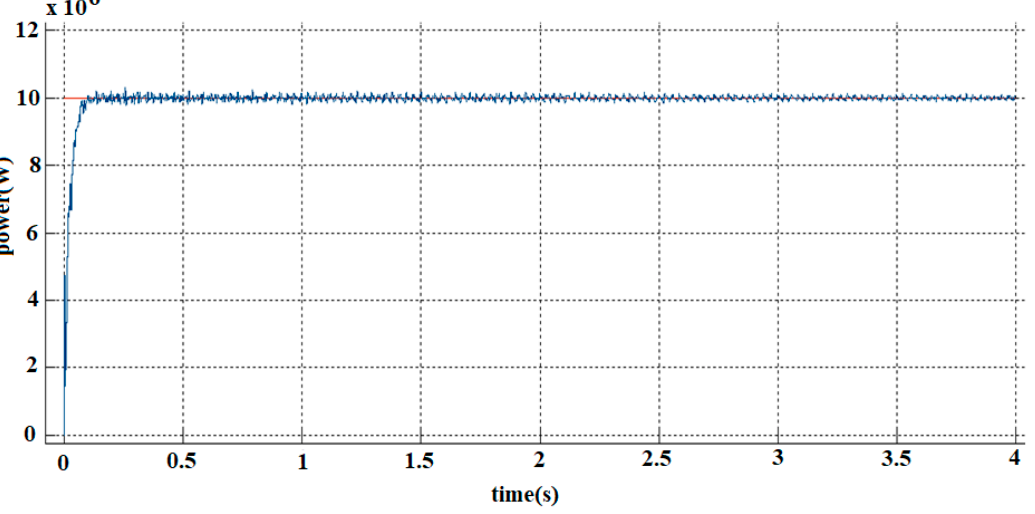
Figure 14. Hexverter active power tracking.